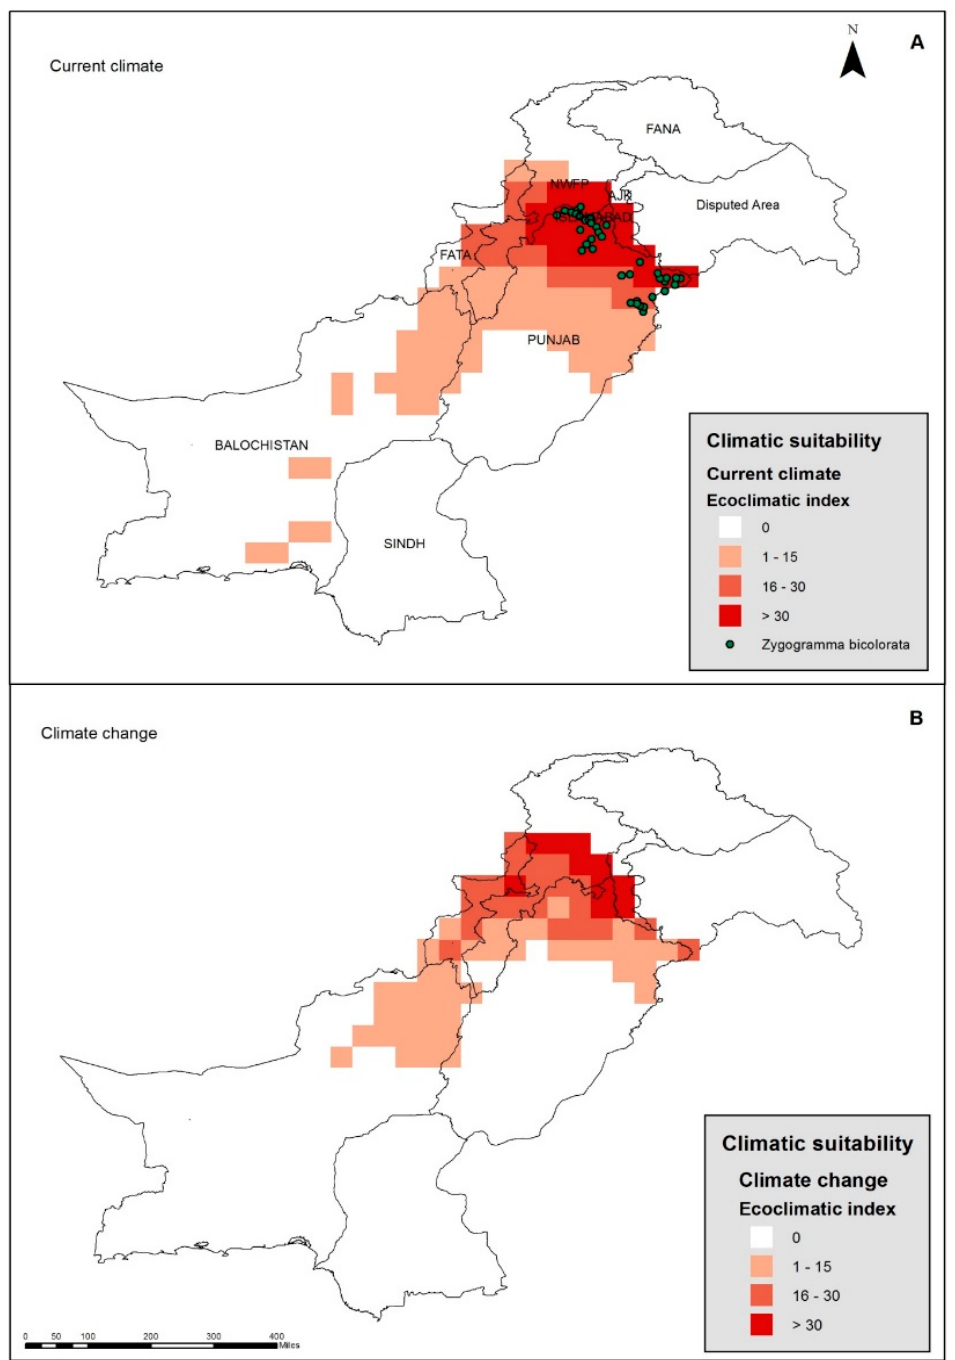
Figure 5. The current distribution of and climatic suitability for Zygogramma bicolorata in Pakistan under ( A ) the current climate and under ( B ) a changed climate with a change of +3 ◦ C and modeled using CLIMEX.